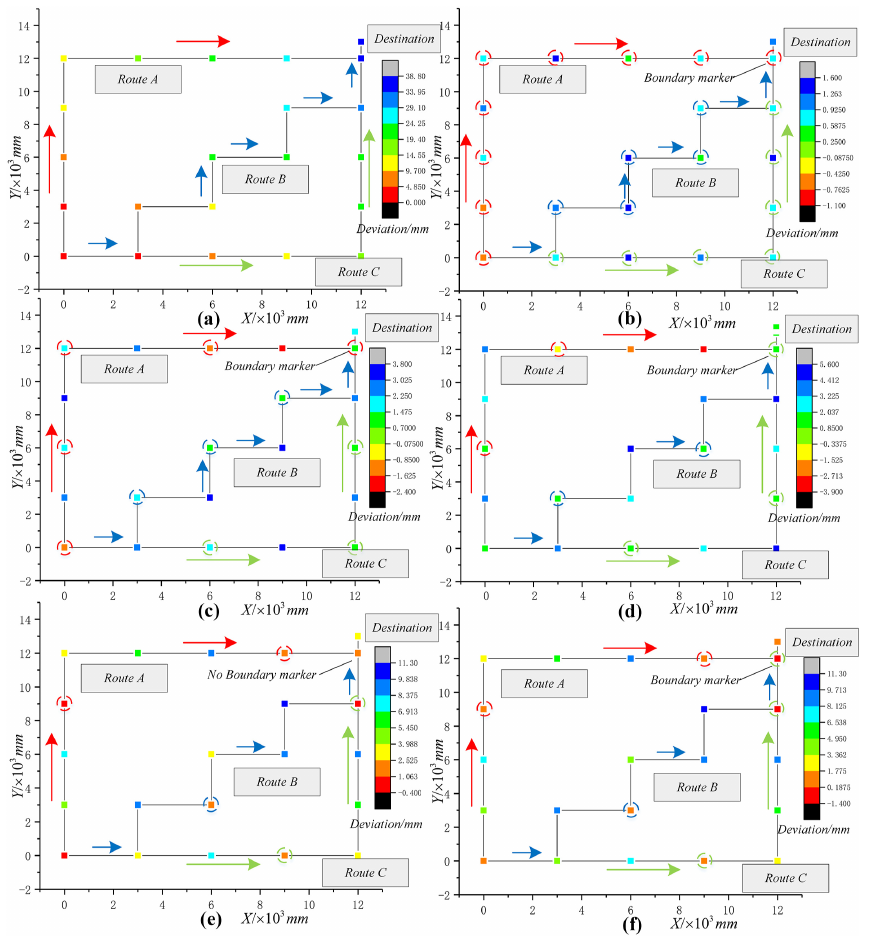
Figure 9. Deviations with different segmentation methods: (a) to (f) are experiments from I to